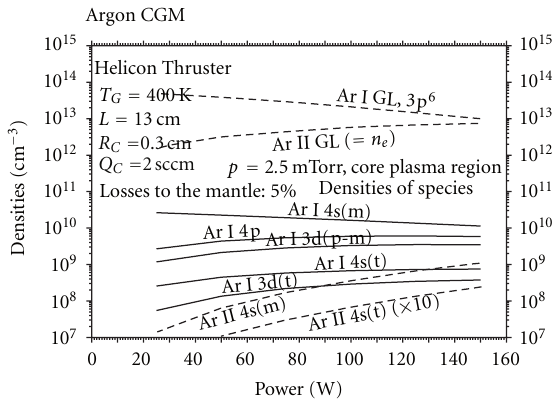
Figure 18: Calculated densities of Ar GL , Ar excited species, and Ar + in the core plasma region.